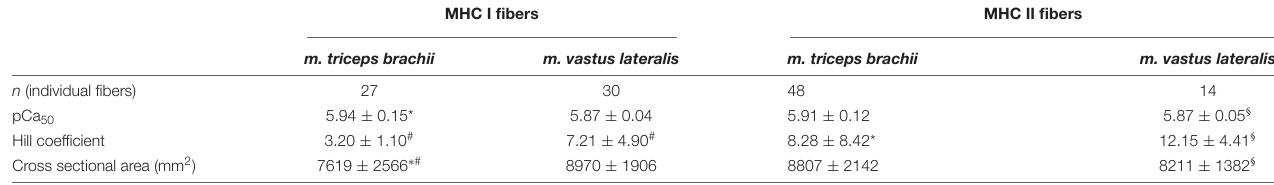
TABLE 1 | The pCa 50 , Hill coefficient and cross-sectional area (means ± SD) of MHC I and II muscle fibers isolated from m. triceps brachii and m. vastus lateralis of eight highly trained cross-country